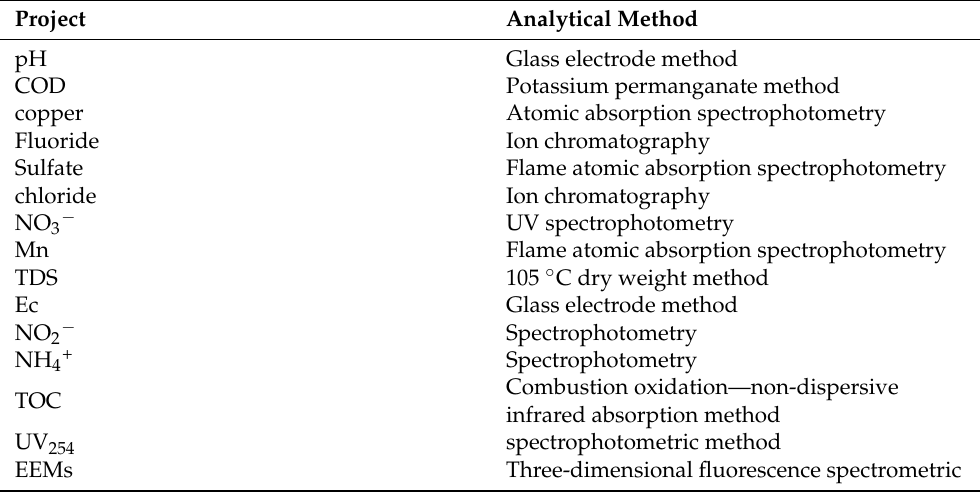
Table 1. Analysis index and methods.